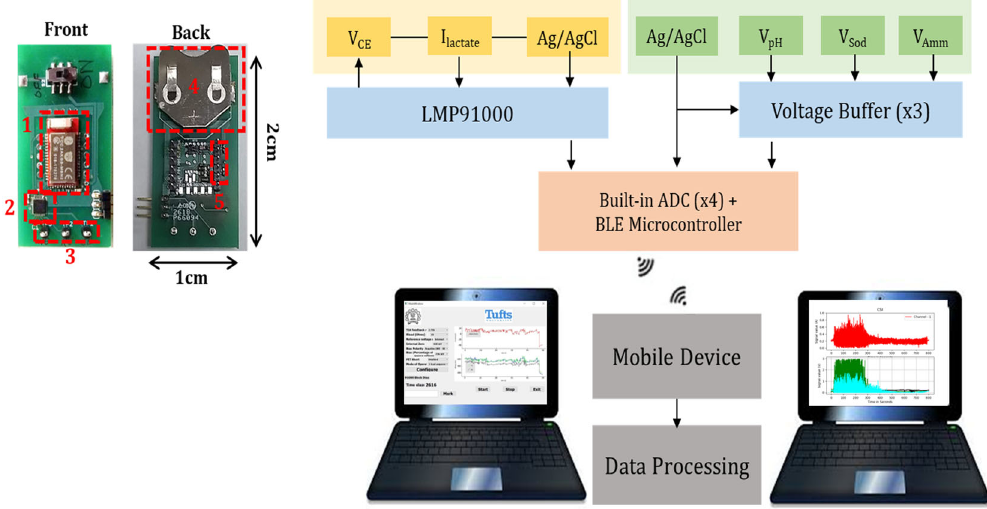
Fig. 6 Wireless readout electronics. Photograph of read out electronic where (1) RedBear BLE Module MB-N2 containing the Nordic semiconductor nRF52832 SoC and chip antenna, (2) LMP91000 con fi gurable potentiostat, (3) amperometric connectors, (4) battery holder CR2032 (3.6 V lithium-ion) battery holder, (5) potentiometric connectors b block diagram of multiplexed sweat sensor patch read out electronics for potentiometric as well as amperometric measurements.